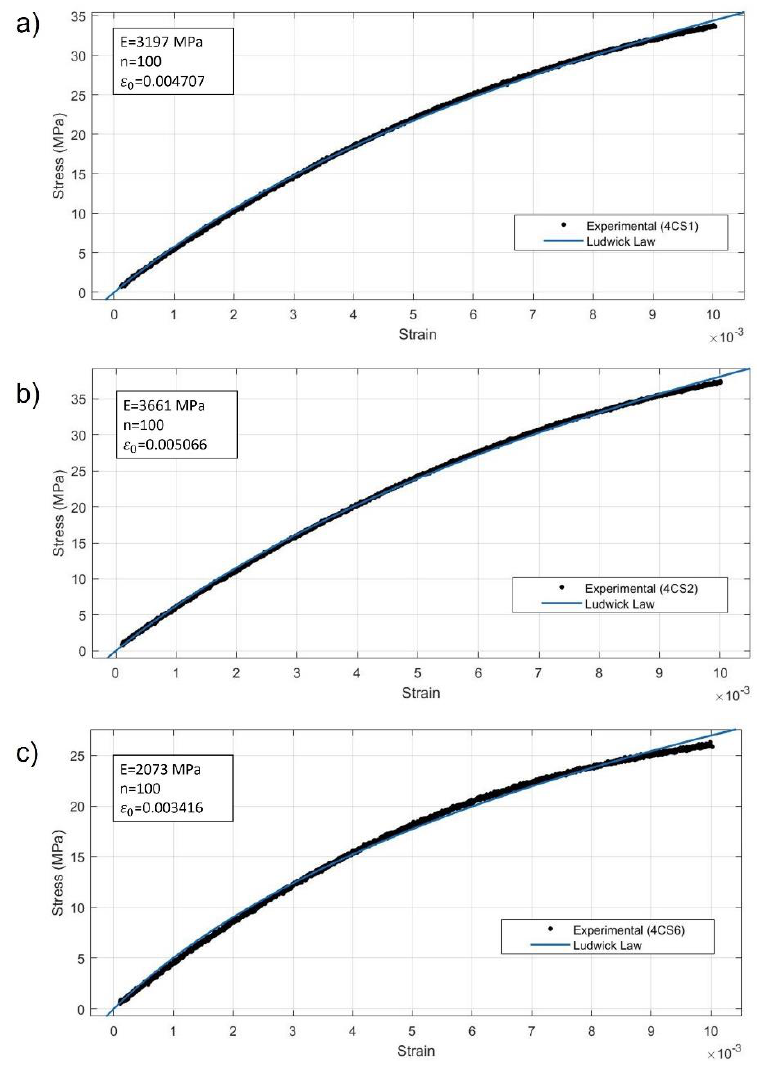
Figure 6. Stress – strain curves of the three representative specimens: ( a ) specimen number 4CS1, ( b ) specimen 4CS2, and ( c ) specimen 4CS6. Curve fitting using modified Ludwick law.